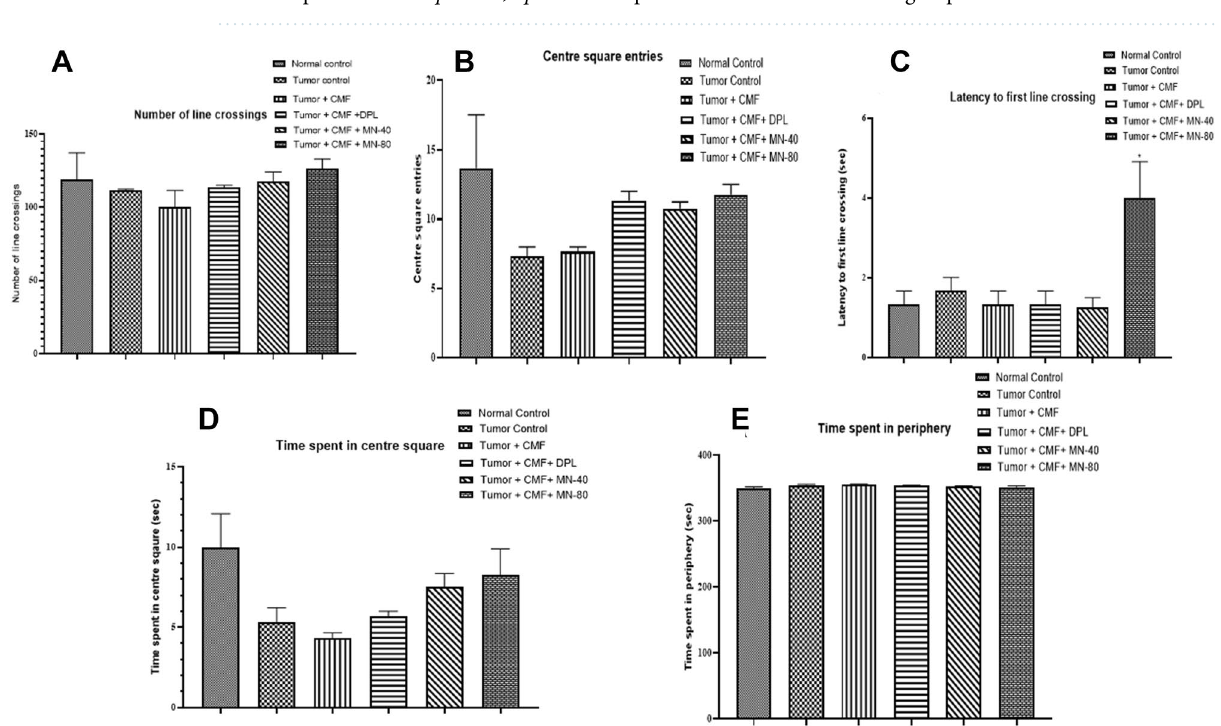
Figure 5. Effect of Mulmina (MN), Cyclophosphamide + Methotrexate + 5-Fluorouracil (CMF), Donepezil (DPL) on ( A ) Number of line crossings ( B ) Centre square entries ( C ) Latency to first line crossing ( D ) Time spent in centre square ( E ) Time spent in periphery on tumor-bearing animals in open-field test. Values are expressed as mean ± SEM (n = 3–4). Statistical analysis was done by using one-way ANOVA followed by Dunnet’s post-hoc test .* p < 0.05 compared to tumor + CMF treated Effect of test drugs on locomotor activity in tumor‑bearing animals. Different parameters such as number of line crossings (total number of lines crossed by each animal in the square area which is divided into 9 equal squares), centre square entries (measure of number of times an animal enters into the centre squares), latency to first line crossing (measure of time taken by the animal to cross the first line from the centre square for the first time), time spent in centre square (measure of total time spent by the animal in the centre square) and time spent in periphery (measure of total time spent by the animal in the periphery of the open-field area). Except for an increase in the latency to first line crossing in the MN-80 treated group compared to the tumour + CMF treated group, none of the treatment groups revealed significant differences in any of the measures. (Fig. 5).